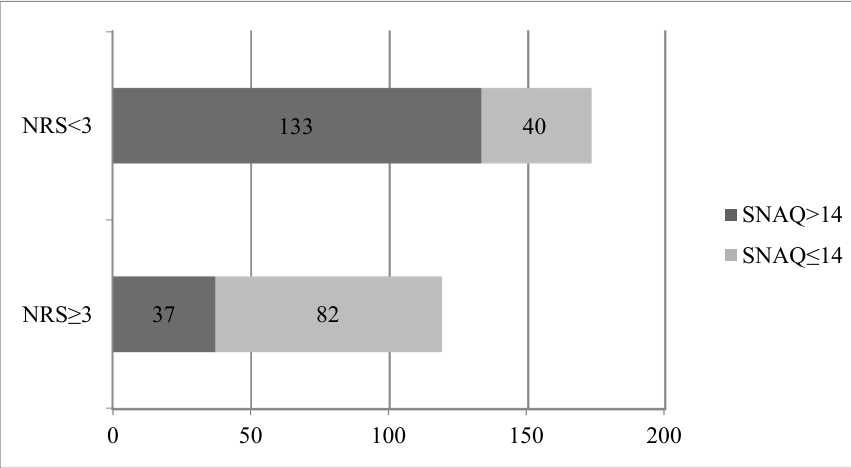
Figure 1. SNAQ: Simplified Nutritional Appetite Questionnaire.